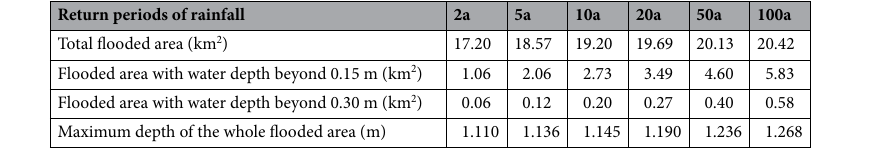
Table 2. Changes in flooded area with various water